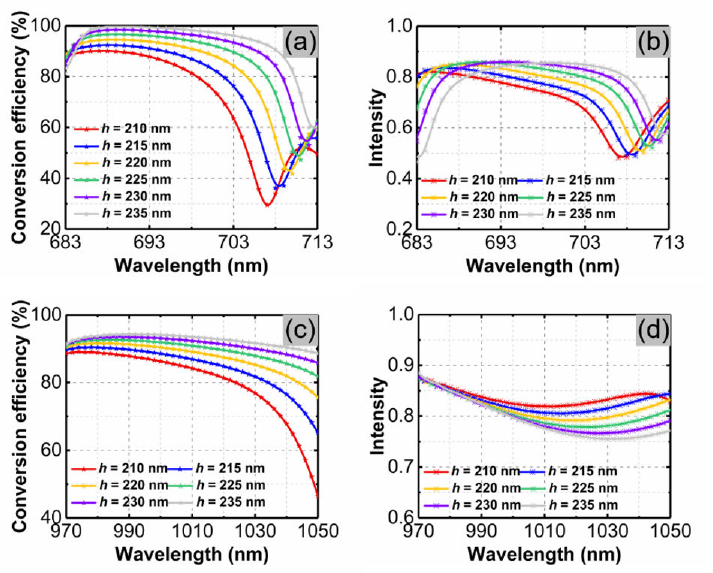
Figure 9. ( a ) Conversion efficiency and ( b ) transmission intensity of metasurfaces with different thicknesses under the incidence of y-polarized light. ( c ) Conversion efficiency and ( d ) transmission intensity of metasurfaces with different thicknesses under the incidence of x-polarized light.